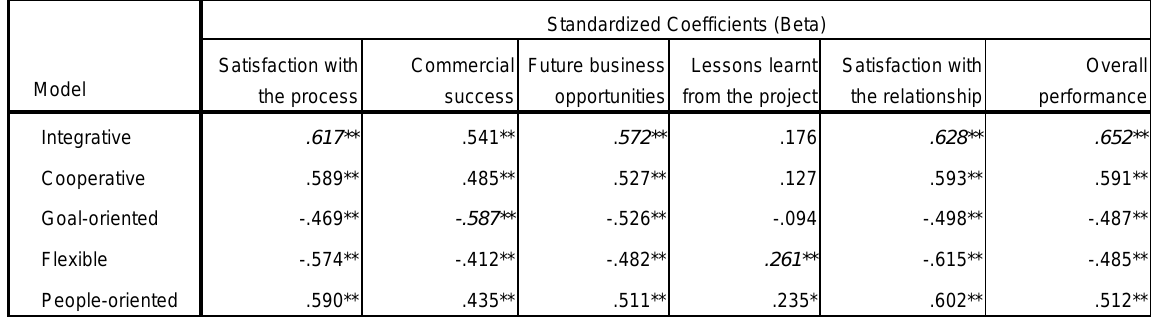
Table 5: Reliability of internal